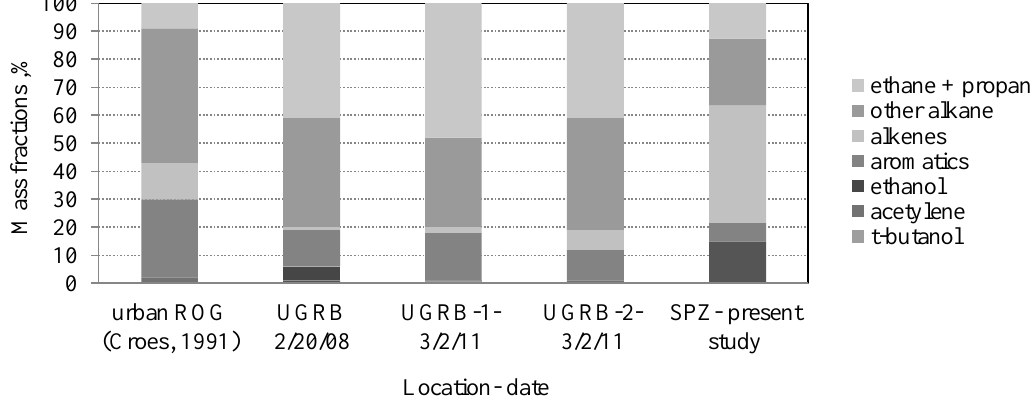
Figure 6. Mass fractions of various types of VOCs in ambient mixtures used in the UGRB simulations for the conditions of two ozone episodes and EI of the SPZ. The urban ROG mixture used in the MIR and other Carter reactivity scale is shown for comparison. The mixtures are grouped by similarity. the picture is reproduced from (Carter,